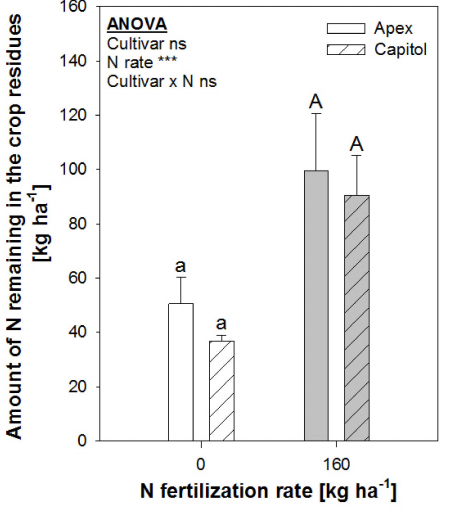
Figure 9. Amount of N remaining in the crop residues (taproot, stem, intact leaves, shed leaves and pod-wall) at maturity of the winter oilseed-rape line-cultivars Apex and Capitol as affected by the N fertilization rate (N0 and N160). Different lower case and upper case letters on the top of the columns indicate differences between the cultivars within the N fertilizer rates at p < 0.05. ANOVA: *** indicates significant differences p < 0.001. ns = non-significant. The error bars represent the standard deviations of the means ( n = 3–4).